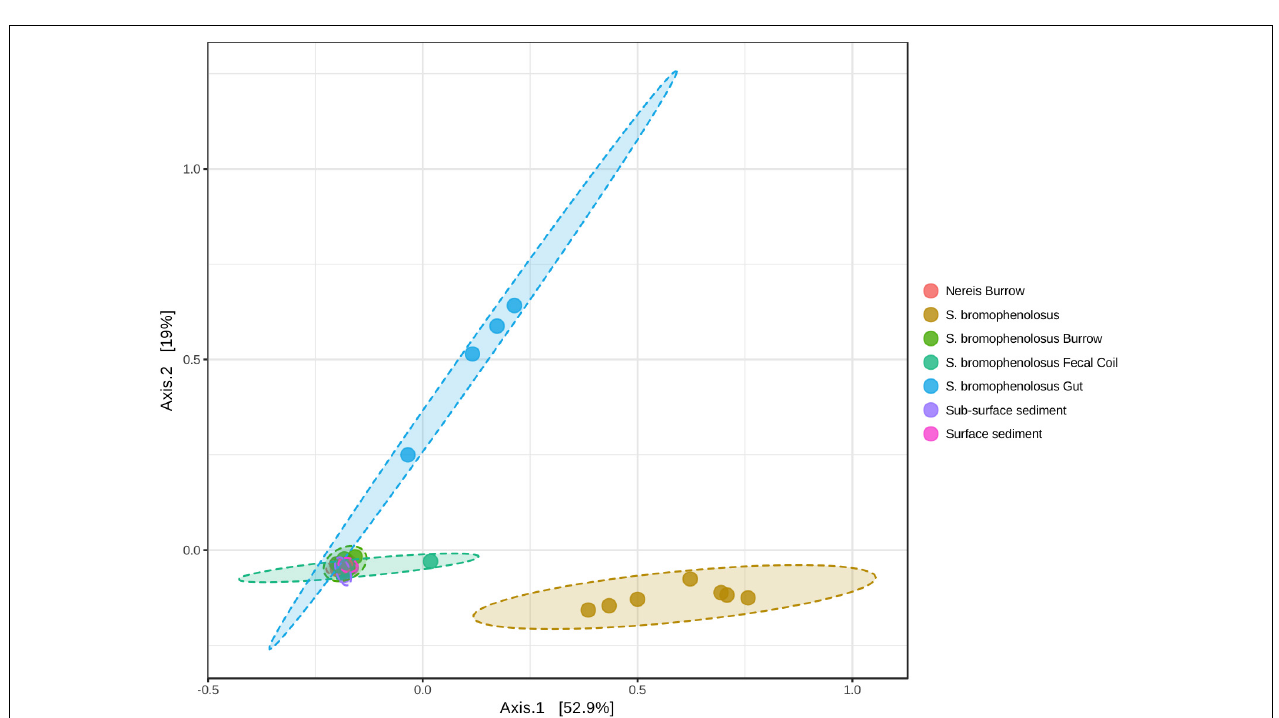
FIGURE 2 | Chao1 index for animal and sediment microbial communities. Chao1 index for whole, sediment-free S . bromophenolosus , S . bromophenolosus gut sediments, and various associated sediments; mean, upper and lower quartiles and data extremes indicated. ANOVA: F = 18.882, p < 0.00001.